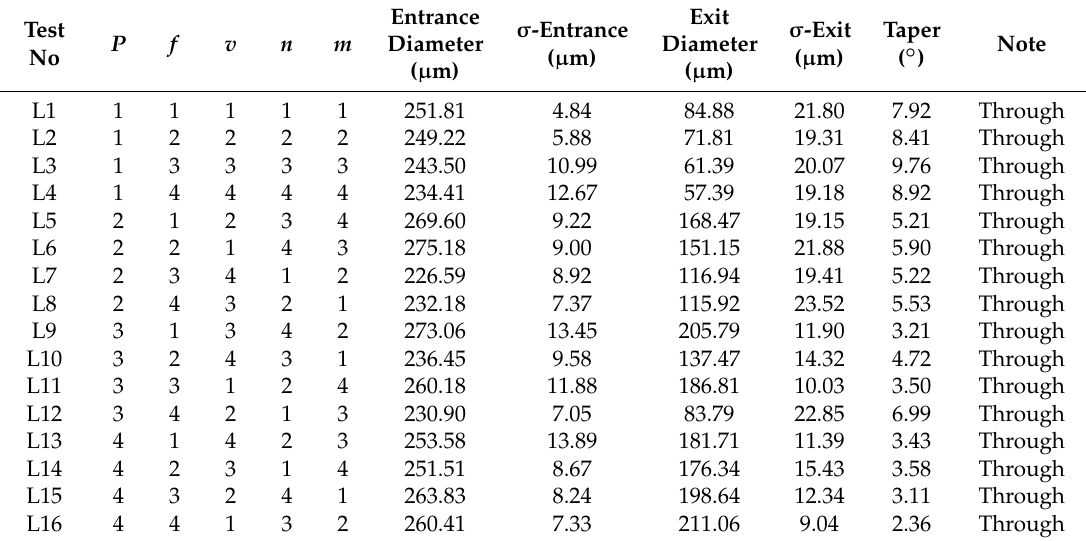
Table 4. Summary of chemical-assisted laser trepanning